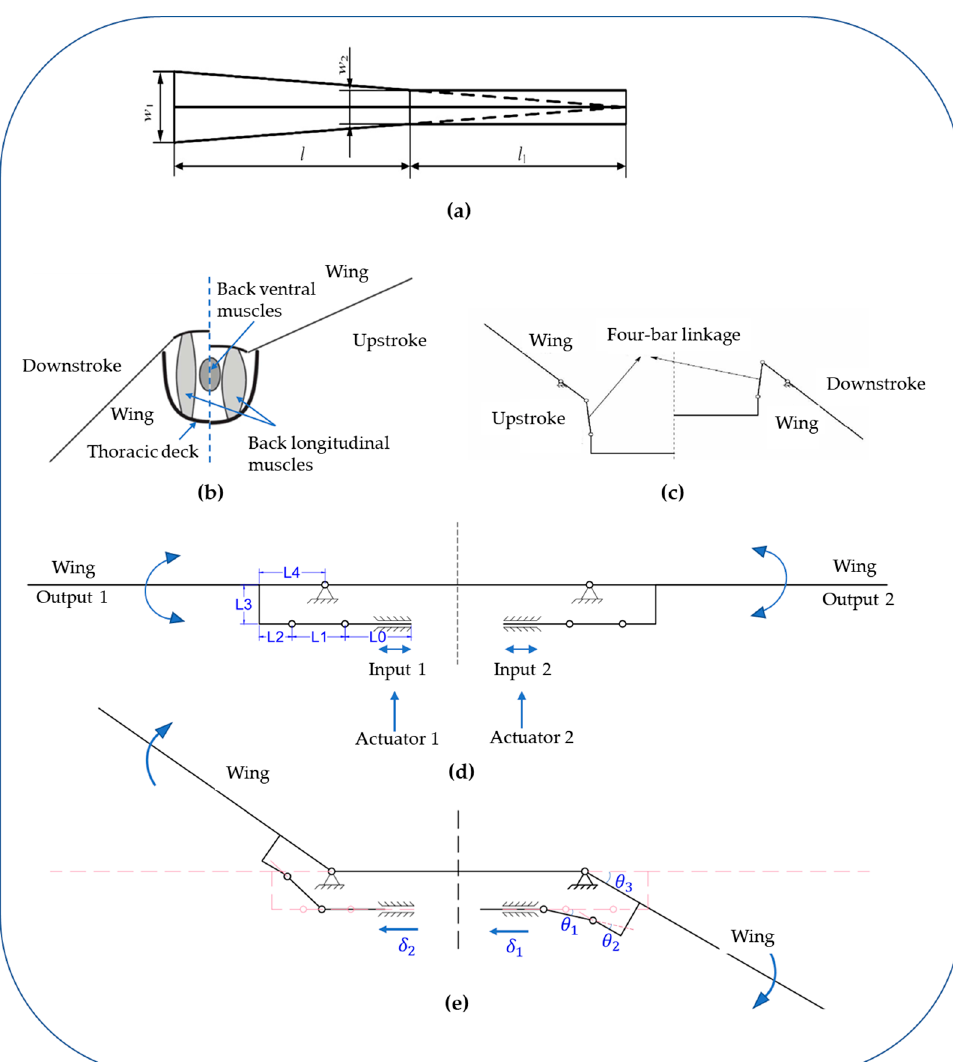
Figure 2. Design of air vehicle mechanism: ( a ) the plane structure of the actuator; ( b ) the structure of the chest cavity of the bee; ( c ) the four-bar linkage mechanism; ( d ) the spherical four-bar linkage transmission mechanism; ( e ) calculation of the transmission ratio of the transmission mechanism.